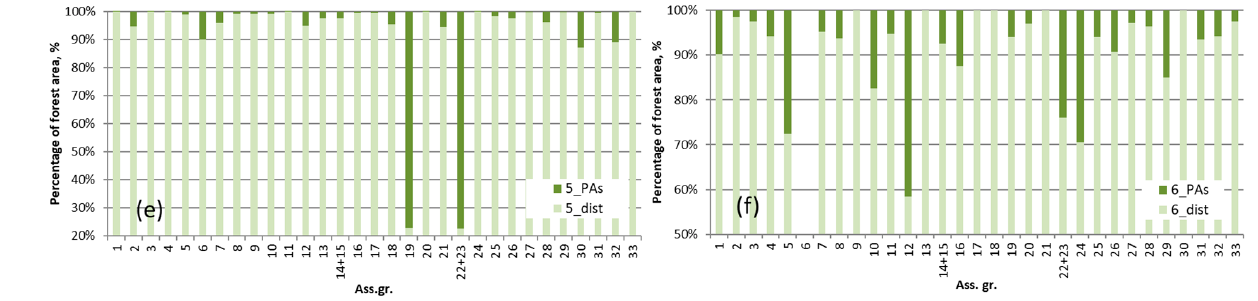
Figure 5. Percentage of forest communities within PAs and the BDs (km 2 ): ( a )—LT, ( b )—MZ, ( c )—NS, ( d )—PK, ( e )—KZ, ( f )—S. Types of communities: 1—Sp_DshShG; 2—Sp_Sh; 3—Sp_ShBh; 4—Sp_Bh;